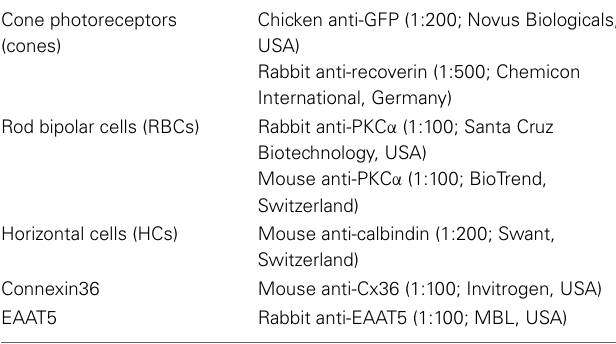
Table listing antibodies for immunolabeling